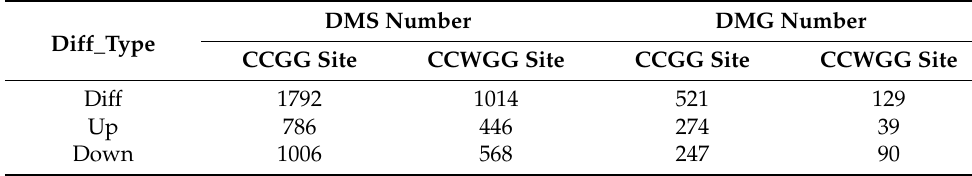
Table 2. The number of DMSs and